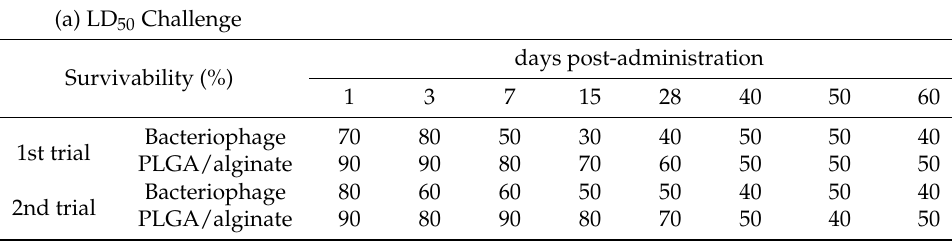
Table 2. The extended prophylactic effect of bacteriophages with or without encapsulation ( n = 10). Challenge with LD 50 (a), and LD 100 (b). The survival rate was observed for 7 days. a ND: not done.